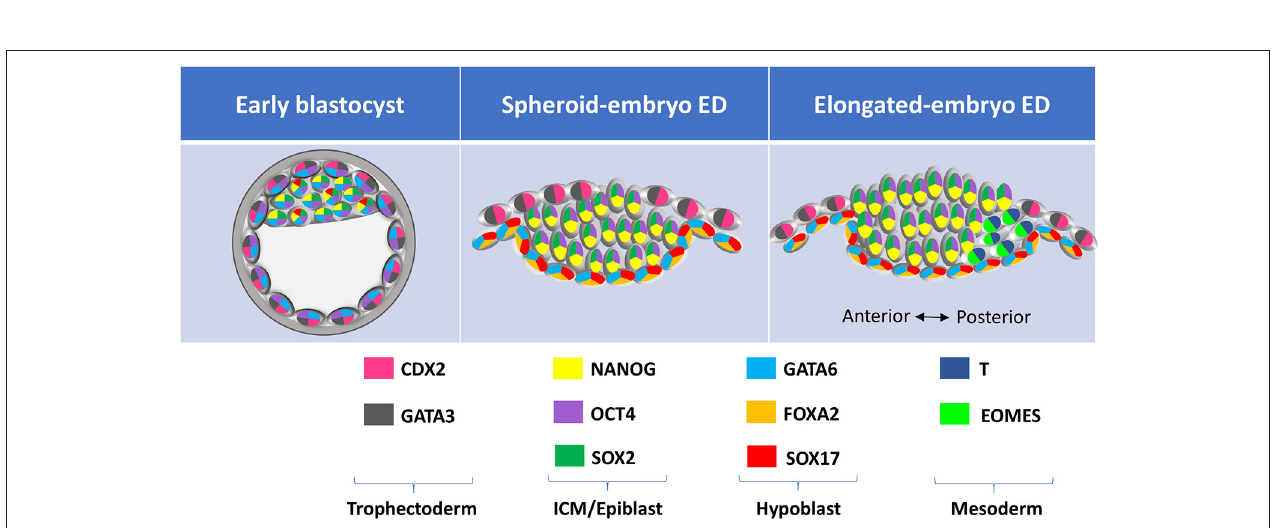
FIGURE 3 | Lineage-specific markers expressed at different developmental stages in farm ungulate embryos. ED, embryonic disc; ICM, inner cell mass; TE, trophectoderm.